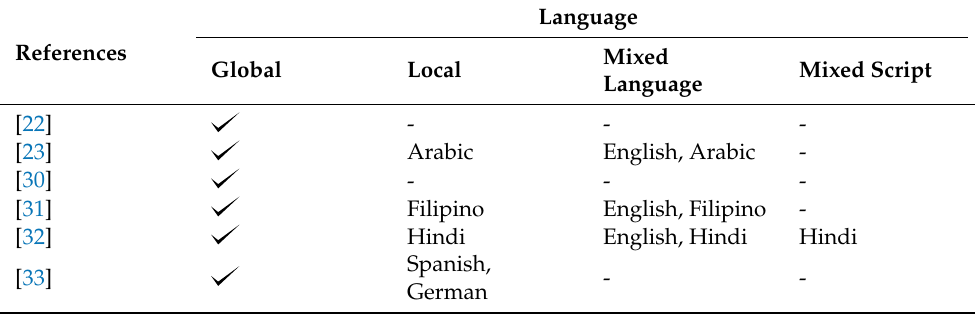
Table 3. Language used on social media for disaster management.